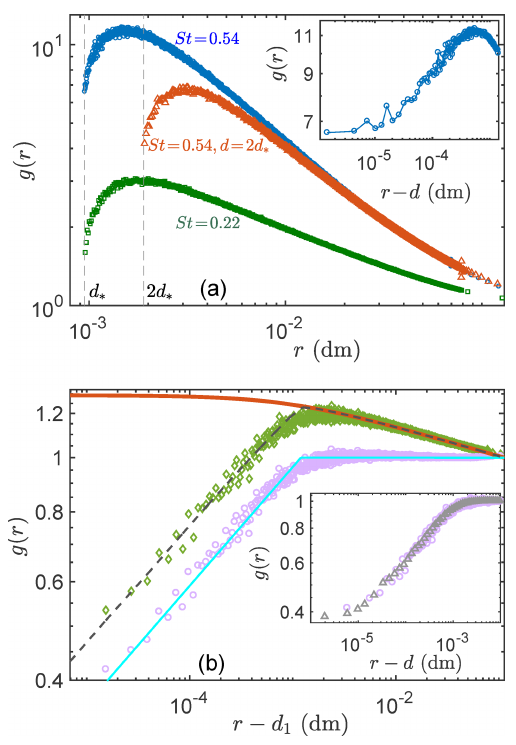
Figure 1. RDFs ( g ( r )) of particles that coagulate upon